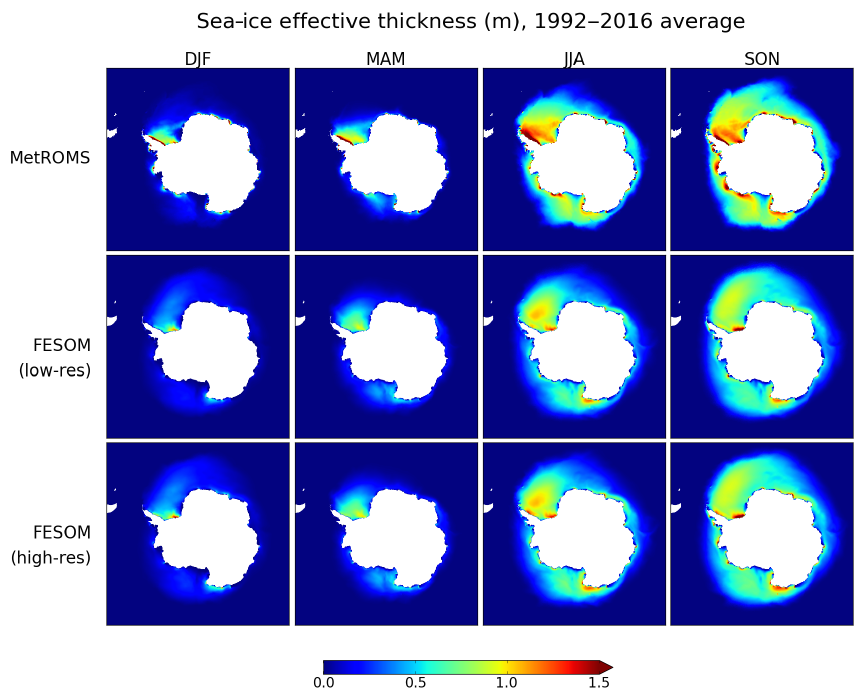
Figure 7. The 1992–2016 mean seasonal Antarctic sea-ice effective thickness (concentration times height, measured in metres) for MetROMS, low-resolution FESOM, and high-resolution FESOM.